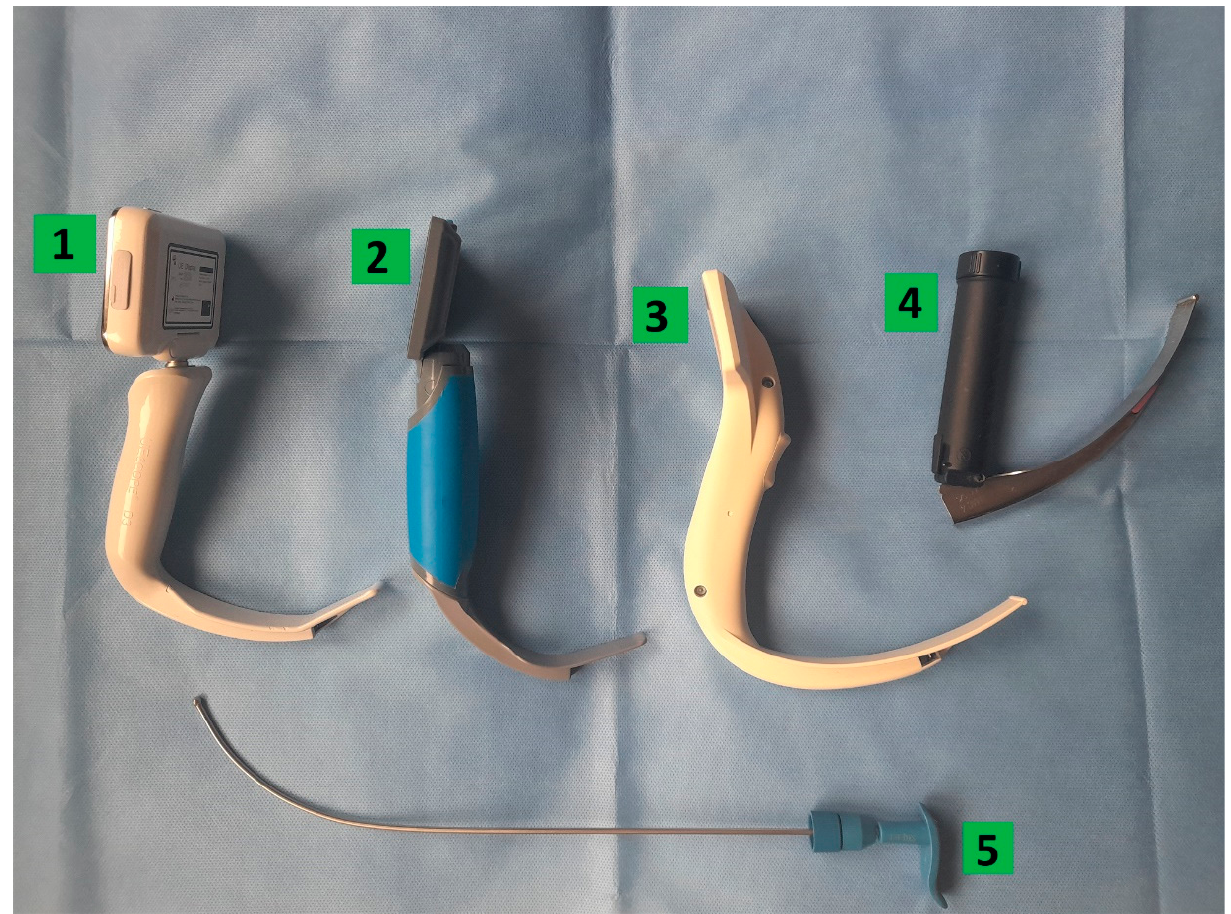
Figure 1. Laryngoscopes used in the study— 1 : UESCOPE ® ; 2 : ProVu ® , 3 : I-view TM : 4 : Macintosh; 5: pro fi led intubation guide.